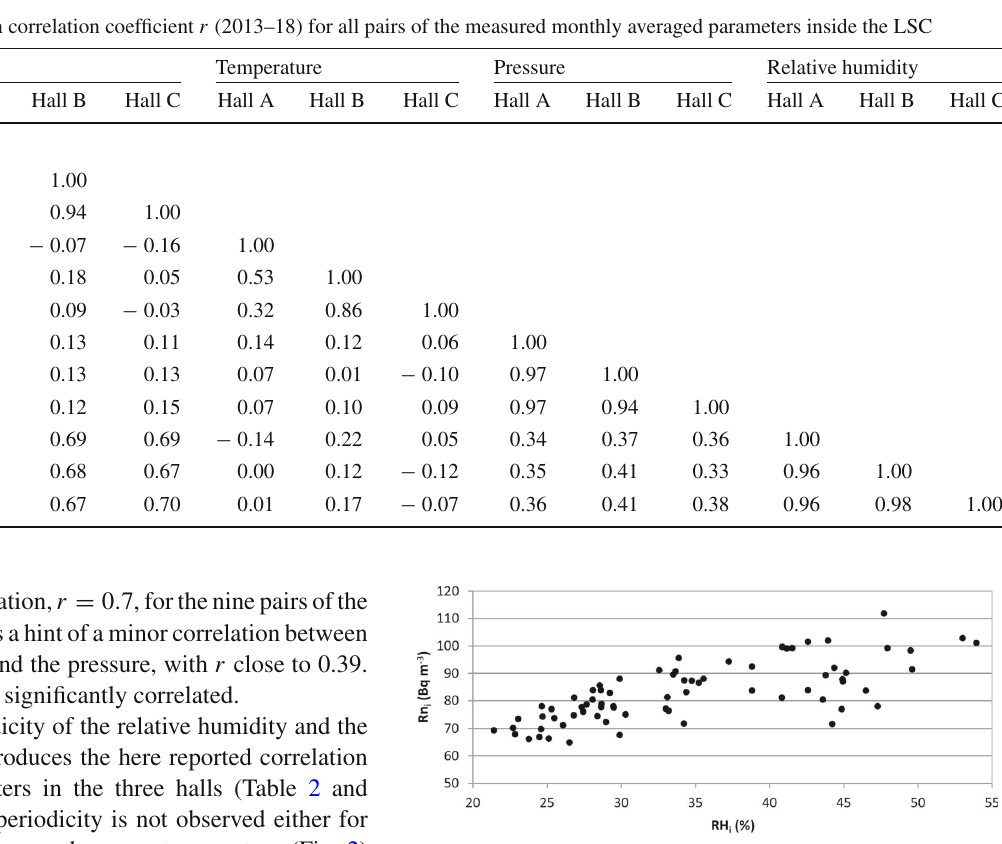
Fig. 4 Monthly averages of the 222 Rn concentration versus the monthly averages of the relative humidity at hall A from 2013 to 2018. Corresponding plots for halls B and C are